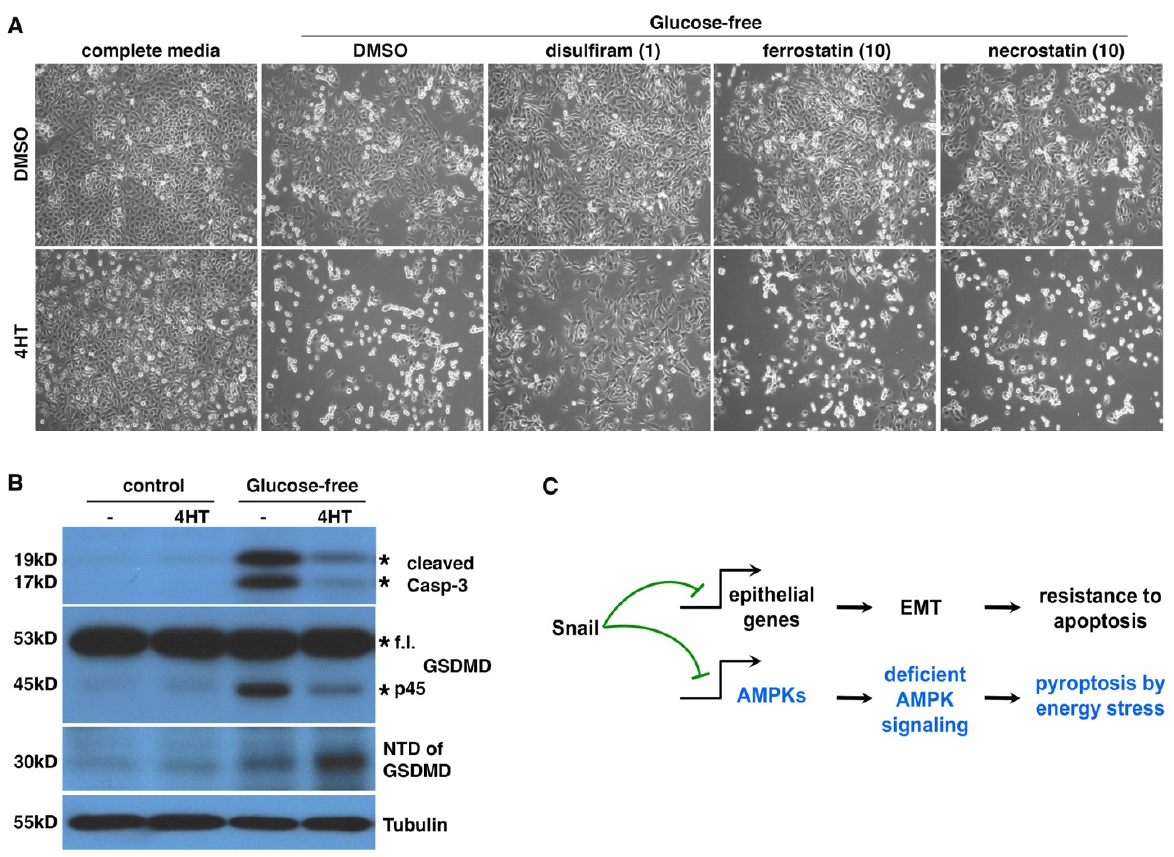
Figure 8. Energy stress induces pyroptosis in EMT cancer cells. ( A ) Disulfiram blocked glucose starvation-caused cell death in EMT cells. DCIS-Snai1-ER cells were treated with 4HT or vehicle (DMSO) for 2 days, followed by glucose starvation [Glc(0)] ± disulfiram (1 µ M), ferrostatin-1 (10 µ M), or necrostatin-1 (10 µ M) for 1 day. The three compounds inhibit pyroptosis, ferroptosis, and necroptosis, respectively. Lower concentrations of ferrostatin-1 and necrostatin-1 also failed to rescue cells (data not shown). ( B ) GSDMD cleavage in EMT and non-EMT cells under glucose starvation. DCIS-Snai1-ER cells were treated with 4HT or vehicle (DMSO) for 2 days, followed by glucose starvation for 1 day, then subjected to immunoblotting with indicated antibodies. Expected protein bands are denoted by asterisks. F.l. full length. ( C ) EMT switches energy stress-induced cell death forms. As Snail independently represses diverse genomic targets, EMT inhibits apoptosis and promotes pyroptosis in cells under energy stress by suppressing AMPK